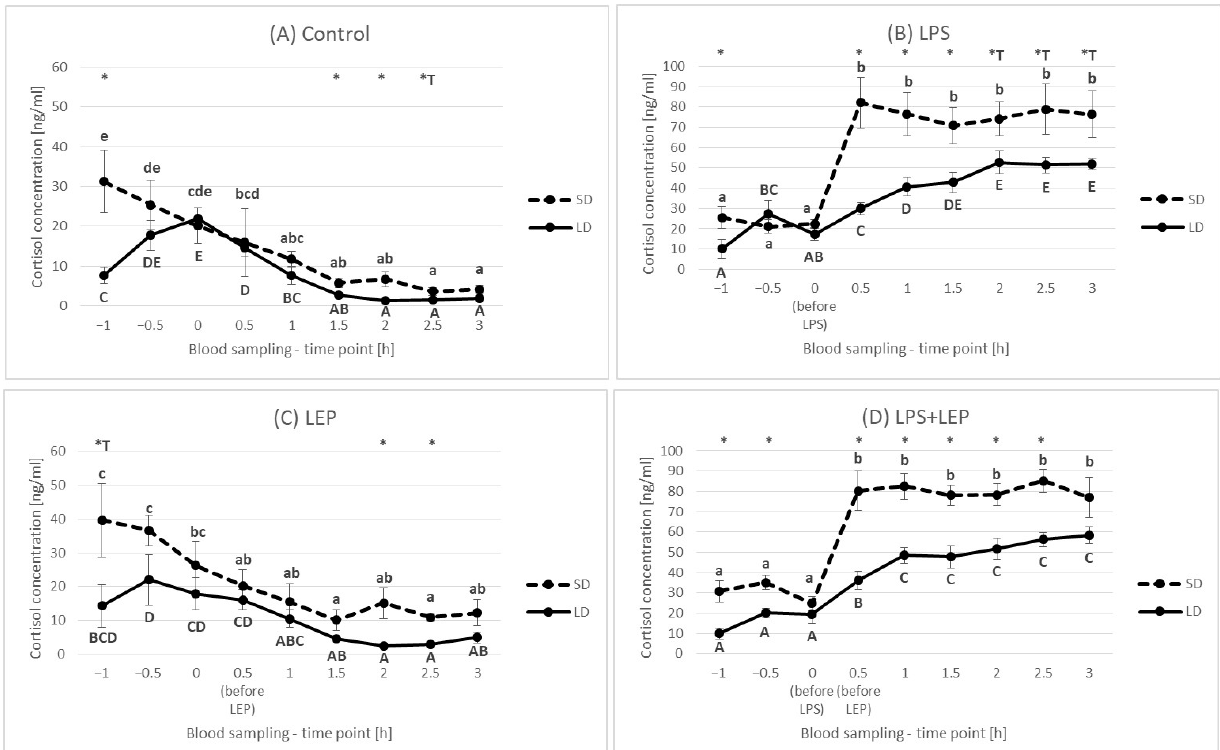
Figure 5. Plasma cortisol concentration for each experimental group separately (Control ( A ), LPS ( B ), LEP ( C ) and LPS + LEP ( D )) at each examined time point and season; *—indicates the statistically significant difference between the short-day (SD) and long-day (LD) photoperiods at each time point according to Student’s t -test ( p ≤ 0.05) ( n = 6); *T—indicates the tendency in a difference between photoperiods at each time point according to Student’s t -test (0.1 > p > 0.05); a–e and A–E—indicate the statistically significant difference between time points for the SD and LD seasons, respectively, according to a repeated measured analysis of variance (ANOVA) followed by Fisher’s post-hoc test ( p ≤ 0.05) ( n = 6). Groups: control—saline injection, LPS—lipopolysaccharide injection at a dose of 400 ng/kg of body mass after a 0 h time point, LEP—leptin injected at a dose of 20 μ g/kg of body mass at a 0.5 h time point, LPS + LEP—LPS and LEP injections at the same doses and time points as those in the LPS or LEP groups.